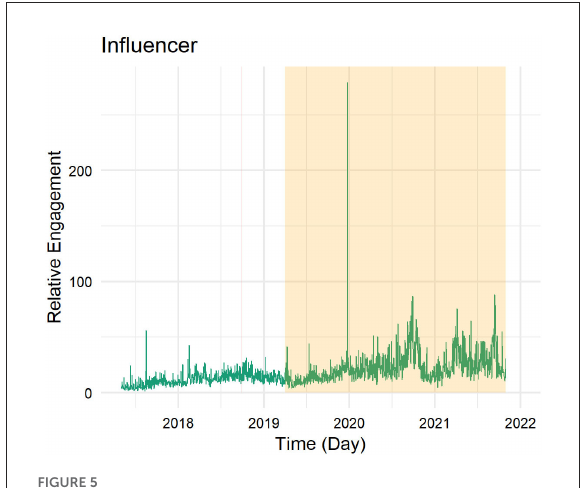
FIGURE5 Twitter engagement received by influencers across time.